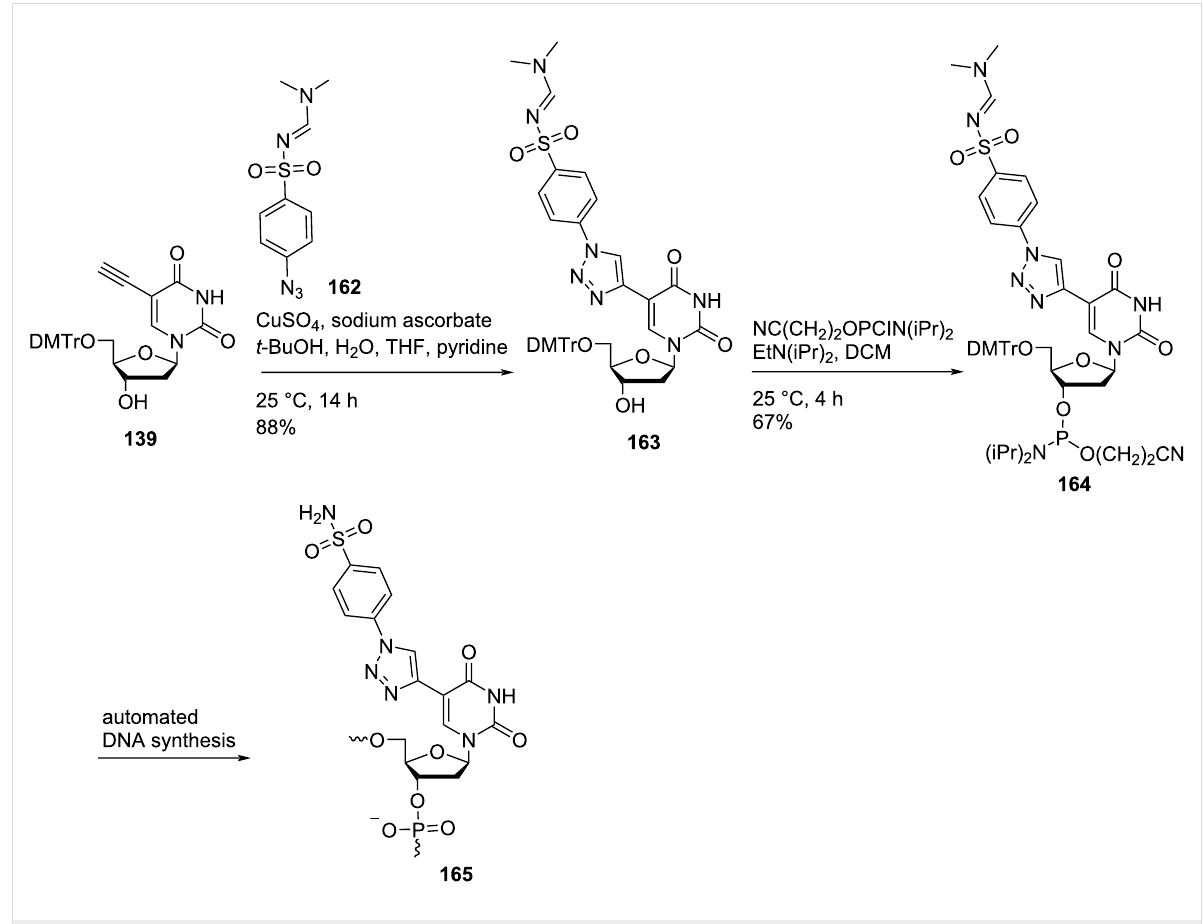
Scheme 42: Synthesis of double-headed nucleoside 163 , phosphoramidite 164 and the corresponding nucleotide monomer 165 .